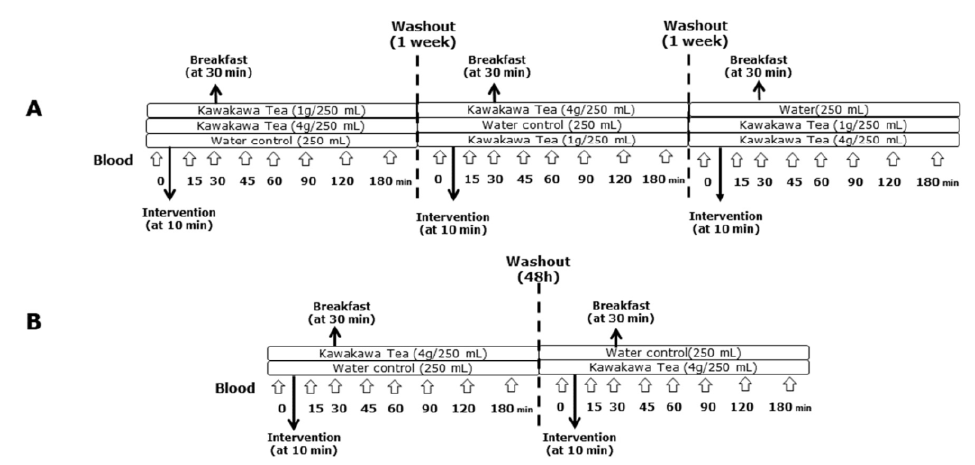
Figure 1. Overview of the study design and intervention. ( A ) A three-arm crossover study (BOKA-T; n = 6) involving three groups; 0 g (only hot water), 1 g (1 g kawakawa/250 mL hot water) and 4 g (4 g kawakawa/250 mL hot water). ( B ) A two-arm crossover study (TOAST; n = 30) involving two groups; 0 g (only hot water) and 4 g (4 g kawakawa/250 mL hot